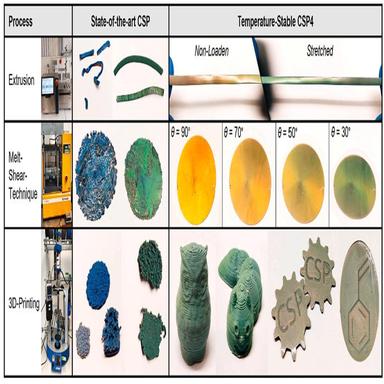
Comparison of state-of-the-art polymer after high-temperature processing with the optimized batch CSP4 after processing at 250 ◦C. State-of-the-art particles are represented by CSP1 (left middle column; blue objects) and CSP3.1 (right middle column; green objects). Both show severe signs of thermally induced deterioration. These samples were not used for other purposes in this work, especially not for reflection spectroscopy measurements. Batch CSP4 was extruded into a homogenous strand with a rectangular c